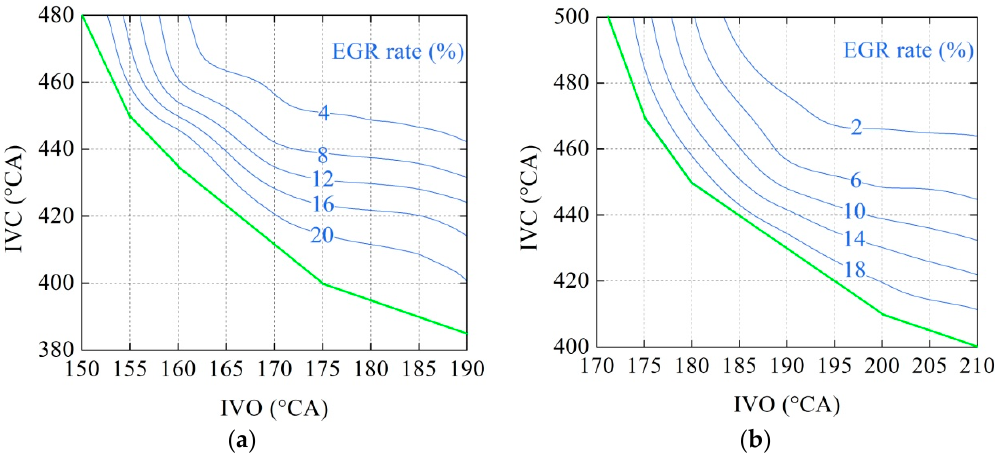
Figure 17. The EGR rate of the active cycle: ( a ) 1200 rpm; ( b ) 1600 rpm.